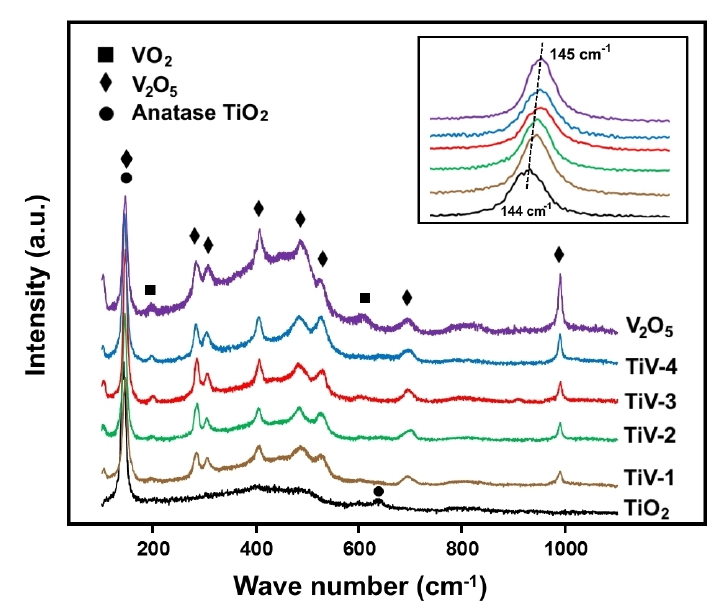
Figure 2. Raman spectra of pure TiO 2 , V 2 O 5 , and TiV1–4 composite samples .